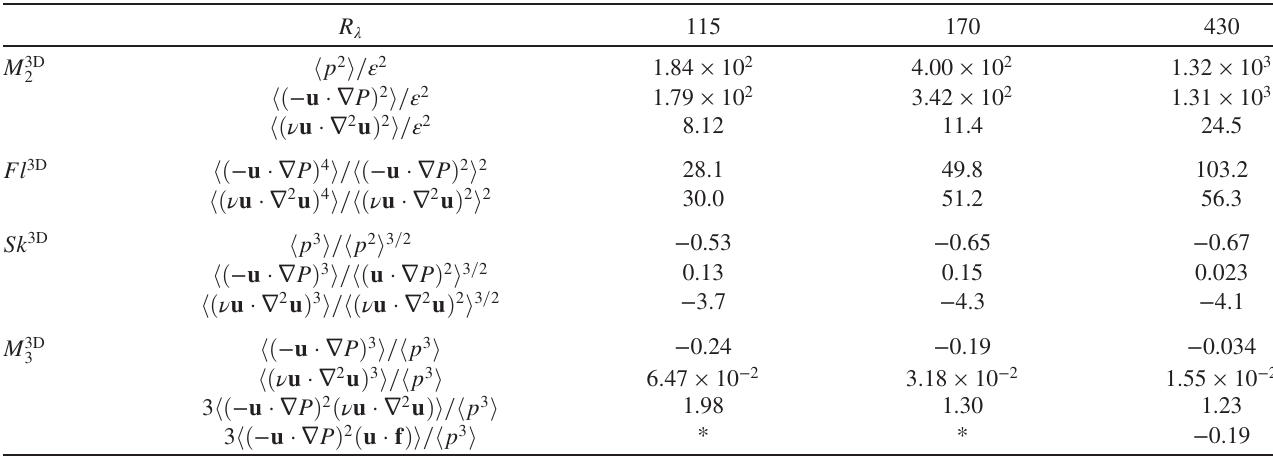
TABLE II. Second and higher moments of terms in Eq. (3) in 3D turbulence. Row M 3 D 2 : Second moments of p , − u · ∇ P , and ν u · ∇ 2 u , all made dimensionless by the energy flux ε . Row Fl 3 D : Flatnesses of − u · ∇ P , and ν u · ∇ 2 u . Row Sk 3 D : Skewnesses of p , h p 3 i from the pressure term, the viscous term, and the two leading − u · ∇ P , and ν u · ∇ 2 u . Row M 3 D 3 : Contributions to the third moment cross-correlation terms. The symbol * means that the terms are not directly available because of the implicit forcing scheme used in those